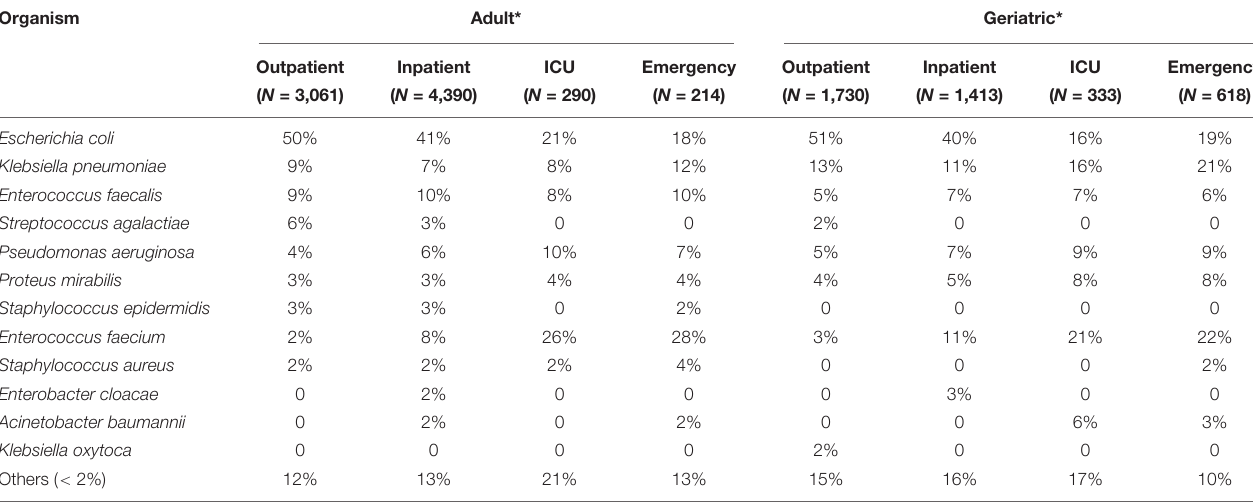
TABLE 2 | Comparison of etiological profile among different ward types among the age categories of adult and geriatric. Organism Adult*